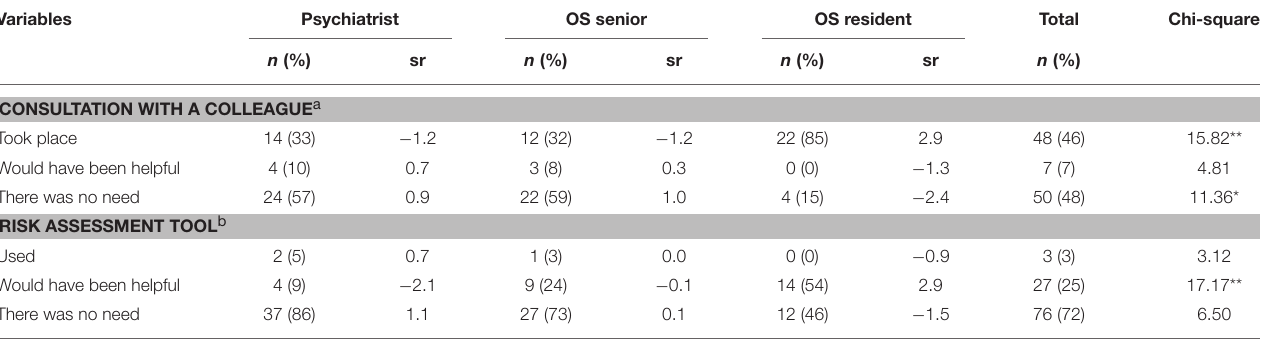
TABLE 4 | Consultation with a colleague and use of risk assessment tool. Variables Psychiatrist OS senior OS resident